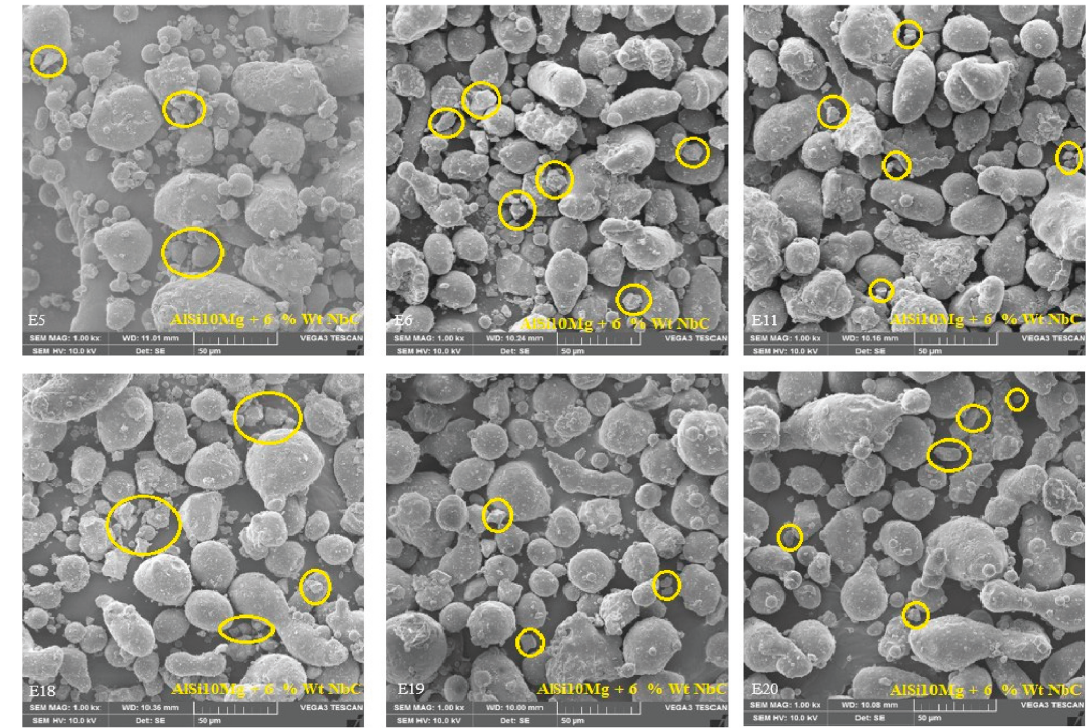
Figure 3: SEM images of center-based experiments.